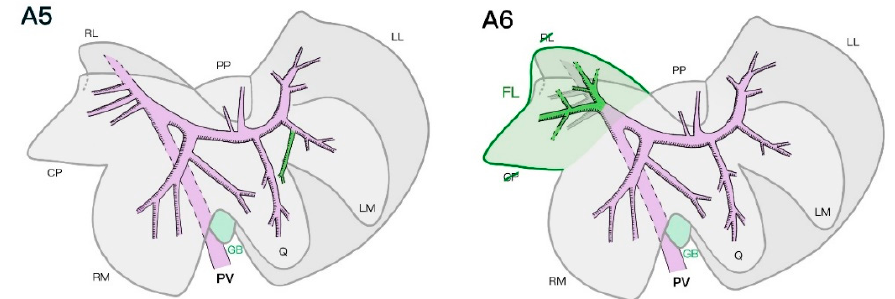
Figure 3. Schematic representation of the intrahepatic portal venous system with the most common number of tertiary branches and its anatomical variations from a parietal view. Most common portal pattern ( A1 ), additional vein to the quadrate lobe from the left portal vein in 2/7 specimens ( A2 ), additional vein to the caudate process in 1/7 specimens ( A3 ), additional vein to the right medial lobe in 1/7 specimens ( A4 ), additional vein to the quadrate lobe from the left medial lobe in 3/7 specimens ( A5 ), and fused caudate process and right lateral lobes in 2/7 specimens ( A6 ). PV, portal vein; LPV, left portal vein; RPV, right portal vein; RL, right lateral; CP, caudate process caudate lobe; RM, right medial; GB, gallbladder; Q, quadrate; LM, left medial; LL, left lateral; PP, papillary process caudate lobe; FL, fused lobe.